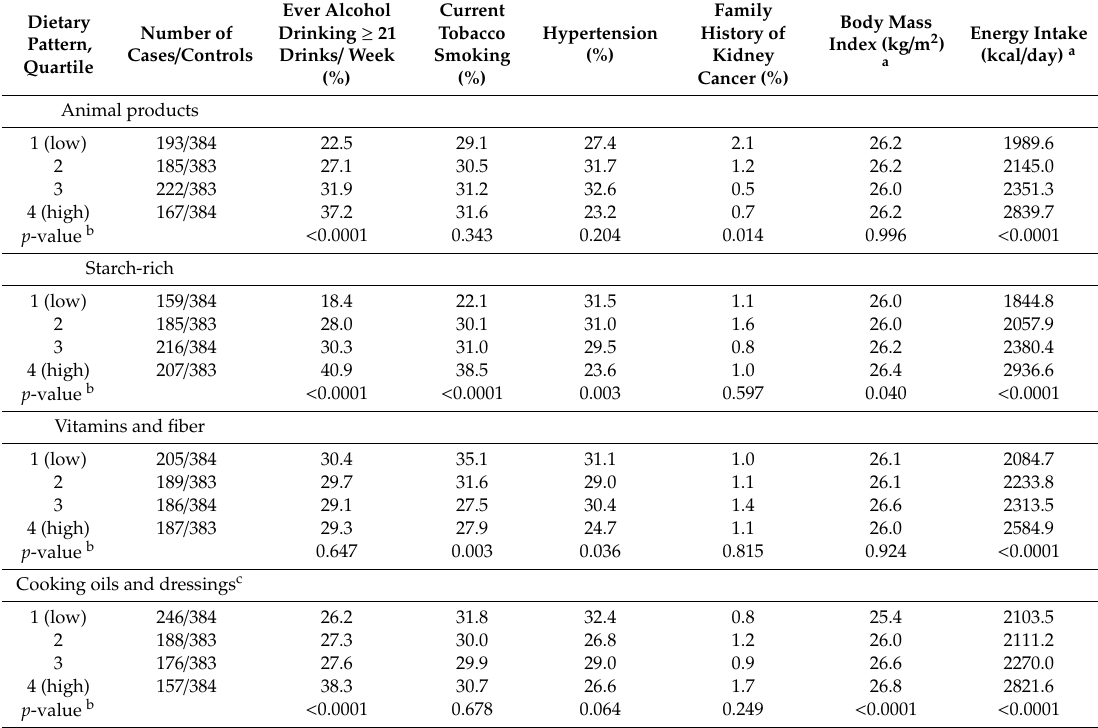
Table 4. Baseline characteristics of the study participants according to quartiles of dietary patterns.